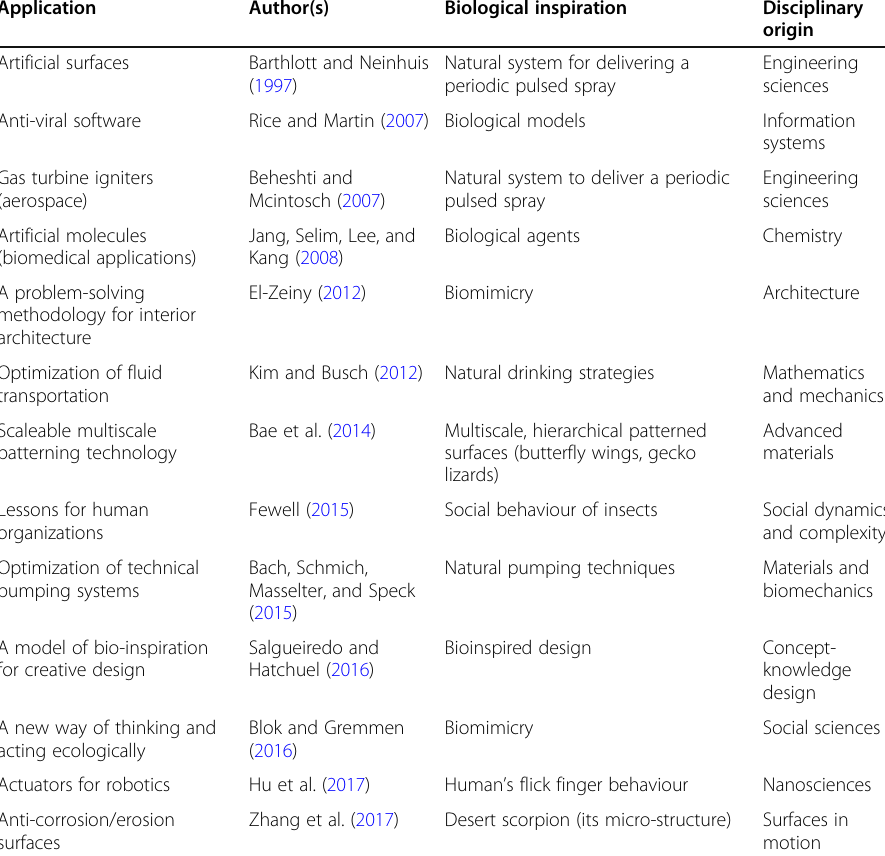
Table 2 Inspirations and areas of application in chronological